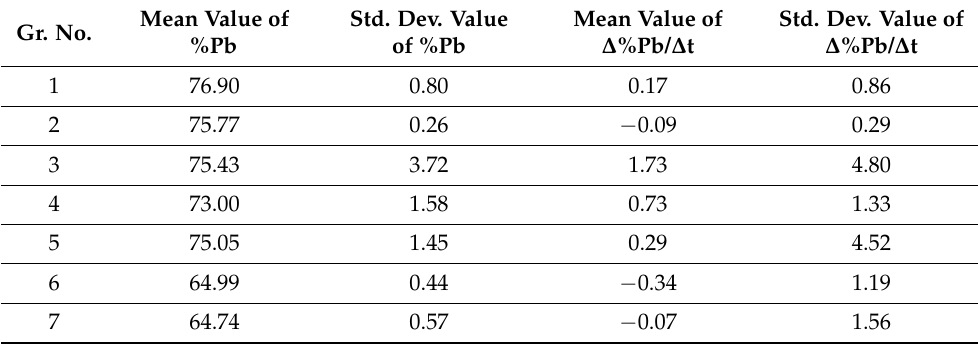
Table 1. Variations in %Pb content in